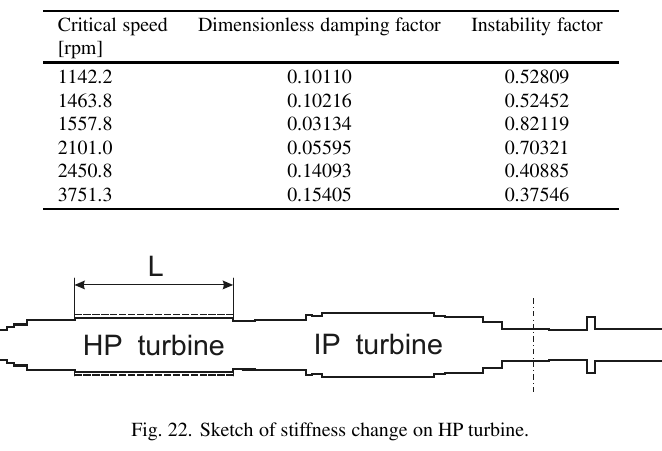
Table 8 Flexural critical speeds and instability factors associated with the fi rst